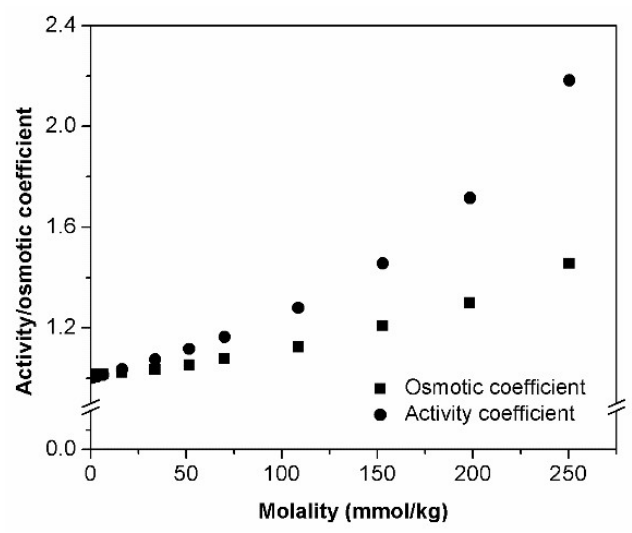
Figure 2. Variation of osmotic/activity coefficients with HPβCD concentration.